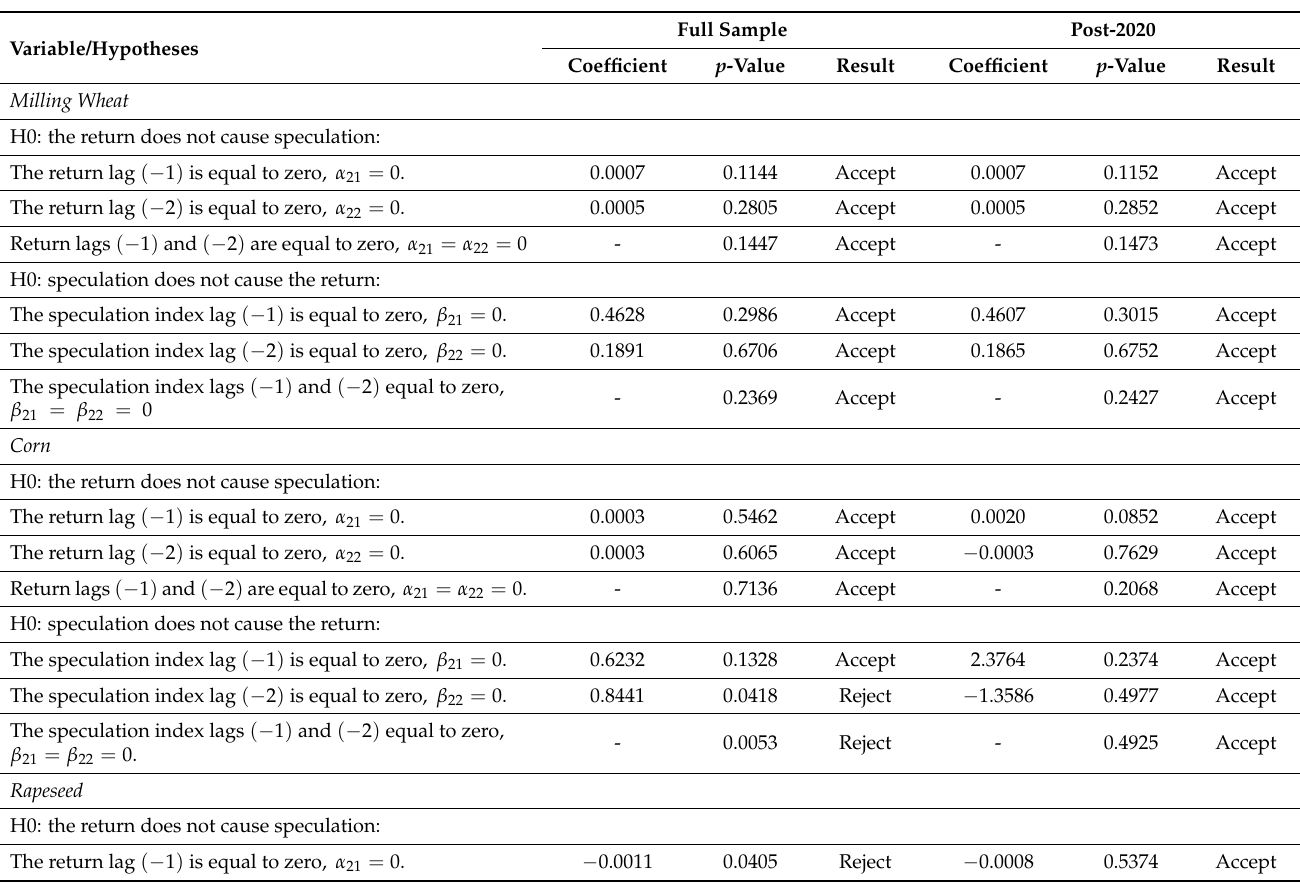
Table 3. Estimates of Granger’s noncausality test using one-day, two-day, and combined